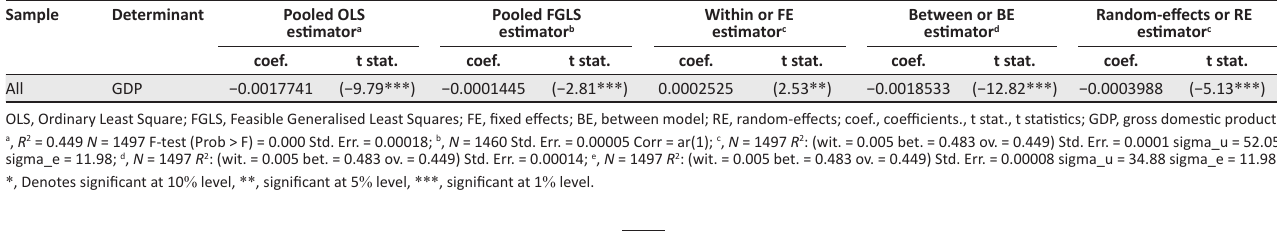
TABLE 5: Variation of Corruption Perceptions Index depends on gross domestic product, by stage of development: All. Sample